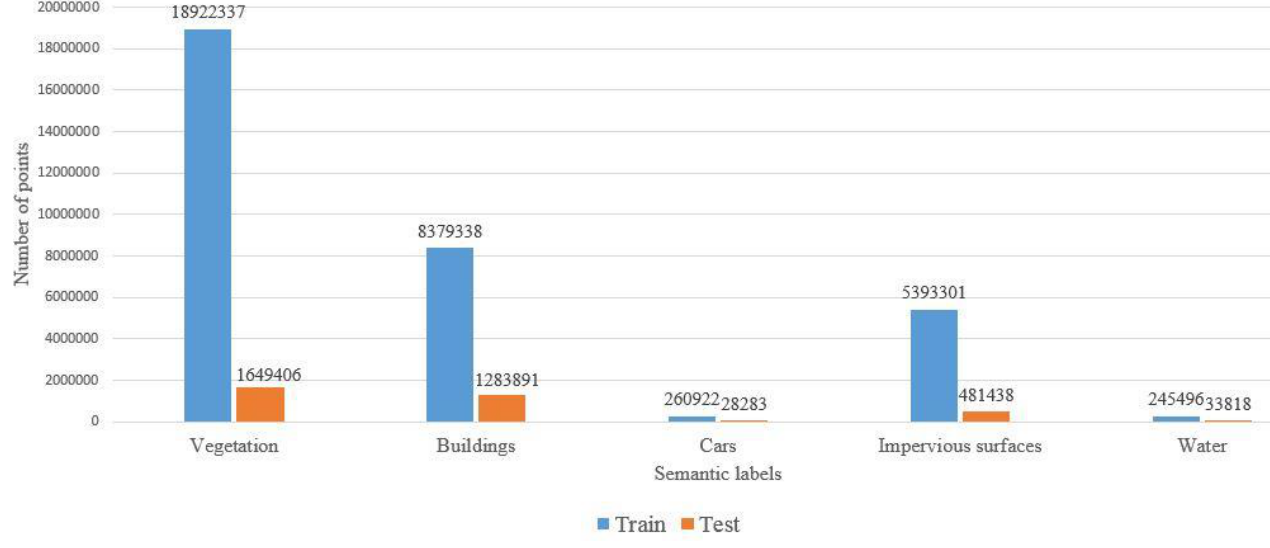
Figure 2. Example of classified point cloud from the created dataset.